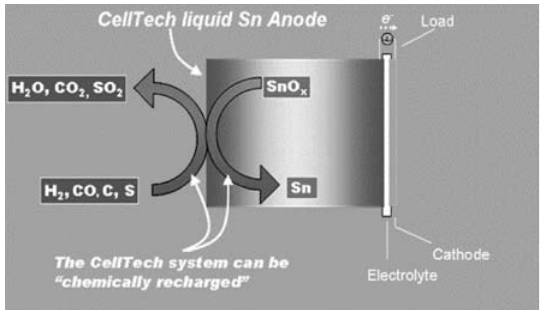
Fig. 4 CellTech DCFC